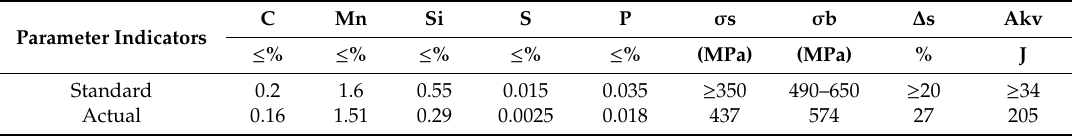
Table 2. Chemical constitution and mechanical properties of test plate.